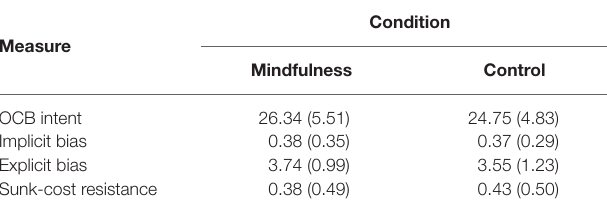
TABLE 1 | Descriptive statistics for dependent variables by